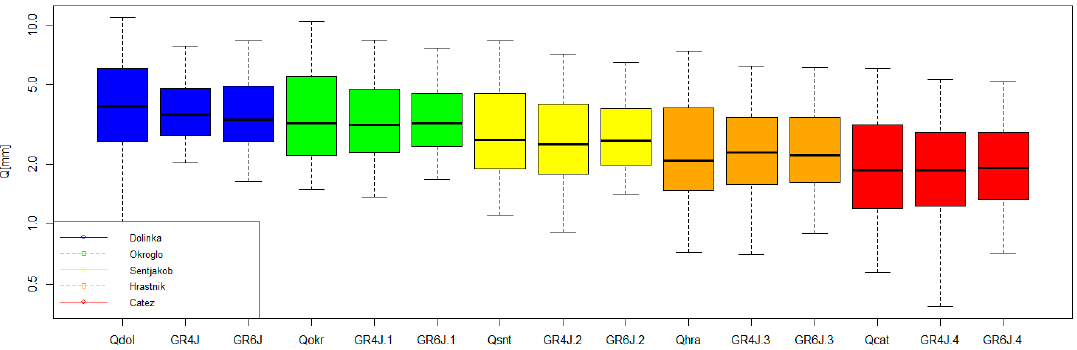
Figure 5. Comparison between modeled and observed discharge data in the validation period for the tested models (i.e., GR4J and GR6J) for five nested sub-catchments.